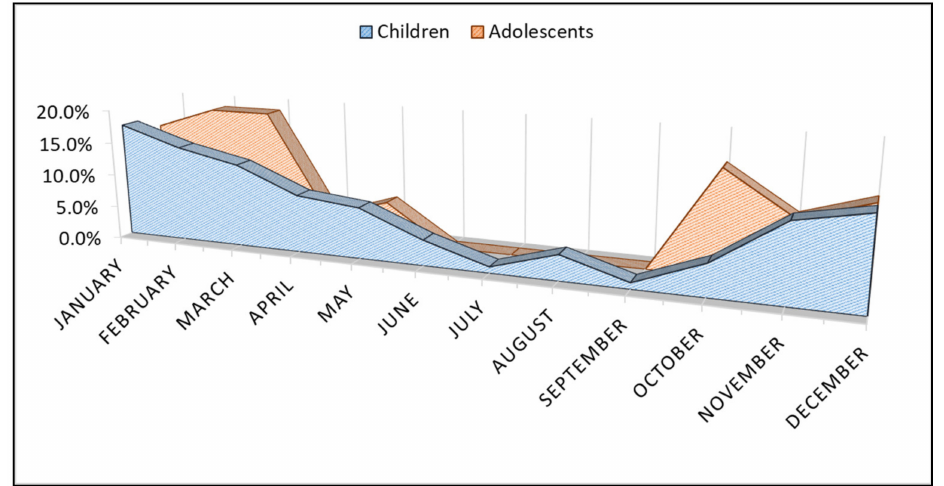
Figure 1. Comparison of measles cases proportions by month of infection with stratification by group of children and